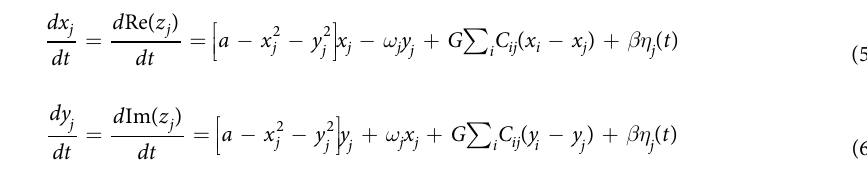
step of . ⋅ ( TR . The parameter G is introduced as a global coupling factor scaling equally all 2